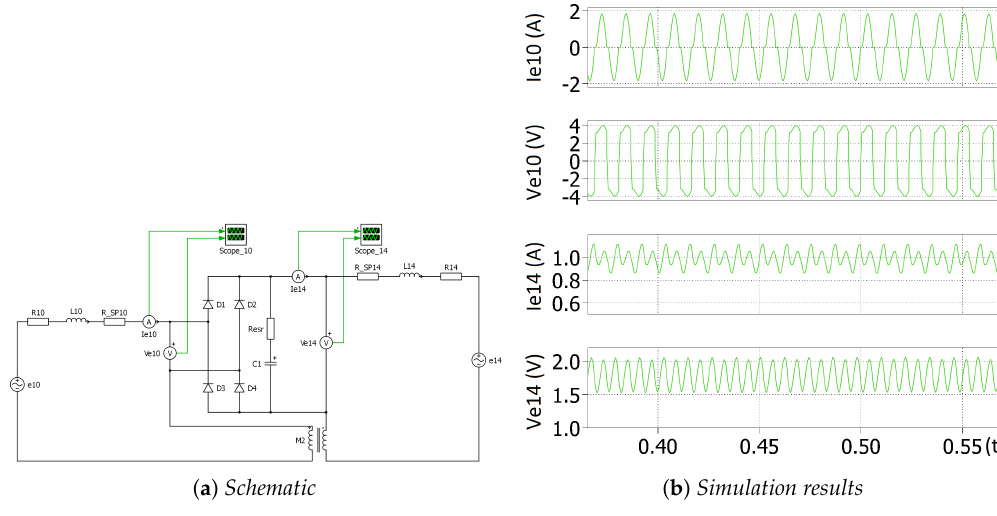
Figure 15. 14th harmonic MMF simulation.